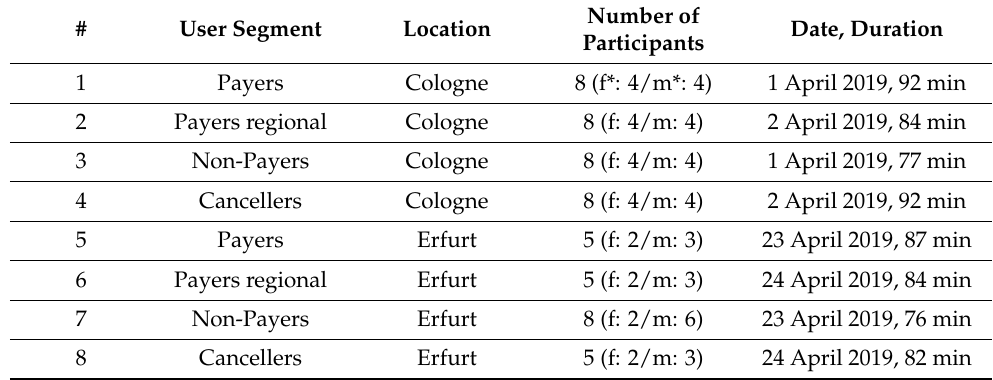
Table 1. Focus group